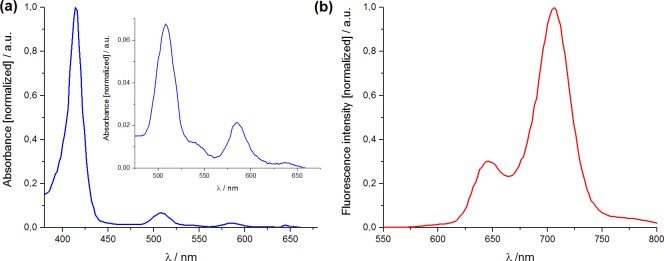
Normalized electronic absorption (a) and fluorescence (b) spectra of fluorinated sulfonated porphyrin (F2POH) registered in EtOH at room temperature. Inset in 2b shows the absorbance profile with multiplied values at λ>450 nm.